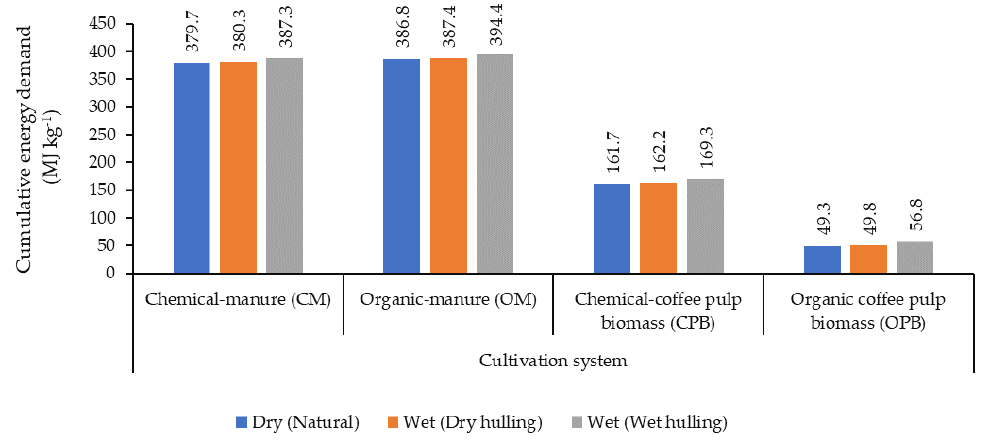
Figure 7. Cumulative energy demand of the life cycle of 1 kg of coffee green bean production from cradle to gate.